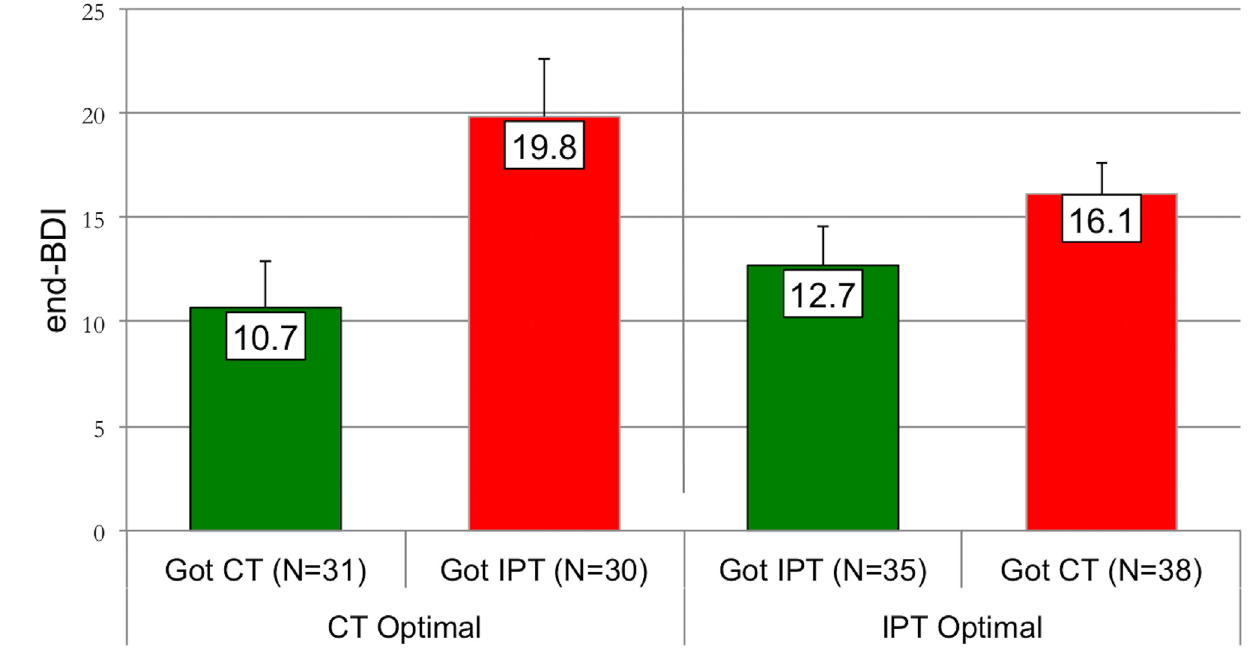
Fig 3. Comparison of observed mean end-BDI scores for patients randomly assigned to their Optimal treatment versus those assigned to their Non-Optimal treatment, by psychotherapy